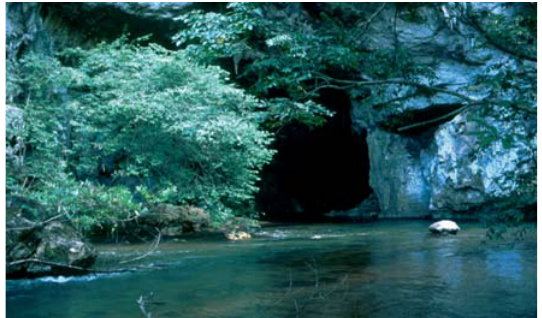
Fig. 1 . Sinkhole of São Vicente Cave System, São Domingos mannia vicentespelaea Triques, 1996. Photo: E. M.